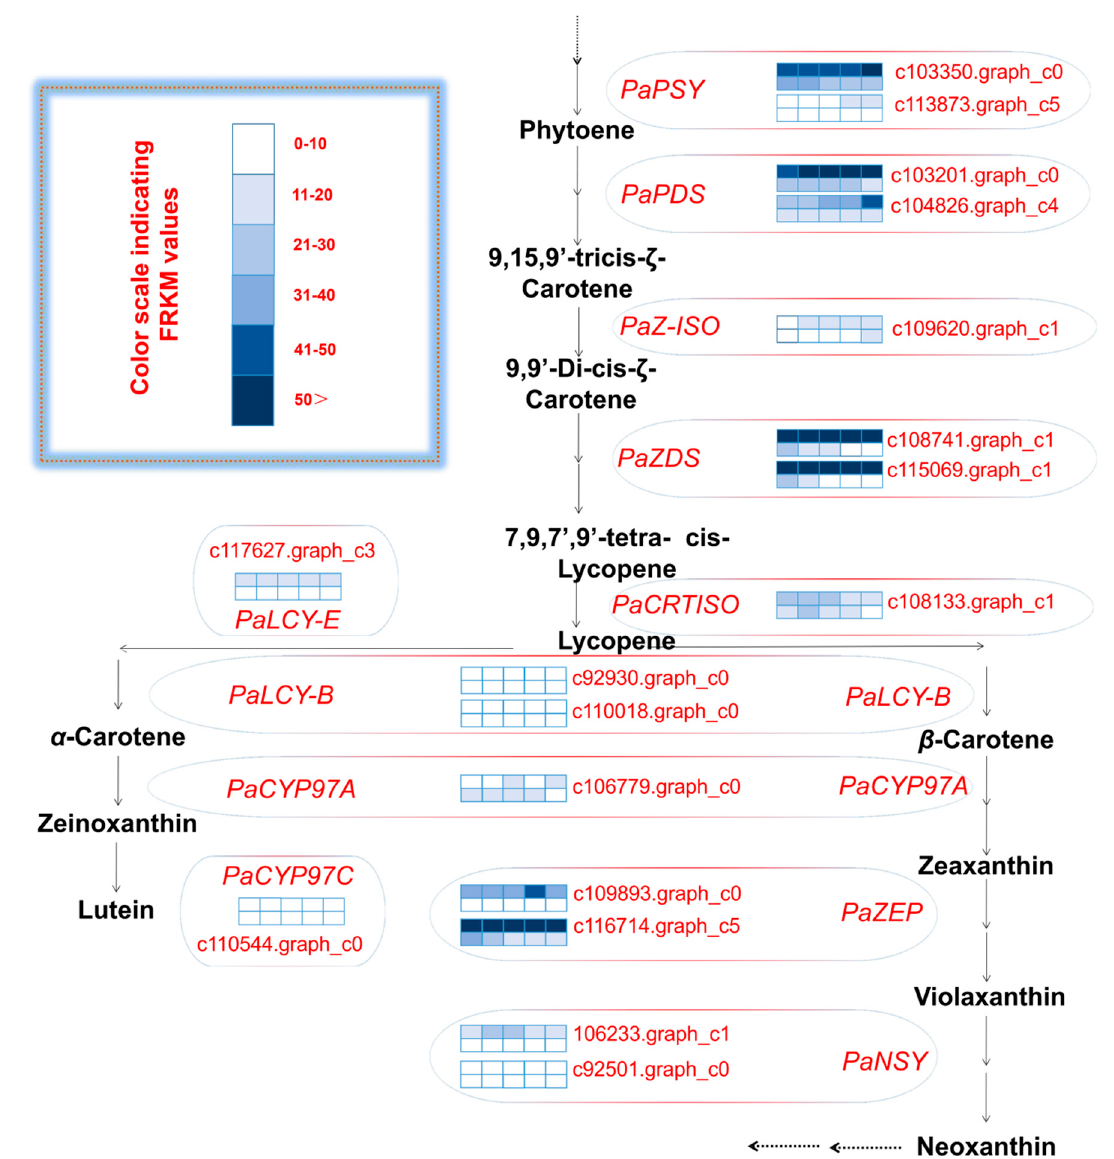
Figure 4. Carotenoid biosynthetic pathway and transcript levels during avocado mesocarp and seed developmental stages. FPKM: fragments per kilobase of transcript sequence per million base pairs sequenced; gene expression levels at 75, 110, 145, 180, and 215 days after full bloom (DAFB) are indicated with colored bars; the top and bottom barfor eachunigene demonstrates avocado mosocarp and seed, respectively; PSY: 15-cis-phytoene synthase; PDS: phytoene desaturase; Z-ISO: 15-cis- ζ -carotene isomerase; ZDS: ζ -carotene desaturase; CRTISO: carotenoid isomerase; LCY-E: lycopene ε -cyclase; LCY-B: lycopene β -cyclase; CYP97A: P450 β -ring carotene hydroxylase; CYP97C: P450 ε -ring carotene hydroxylase; ZEP: zeaxanthin epoxidase; NSY: neoxanthin synthase.